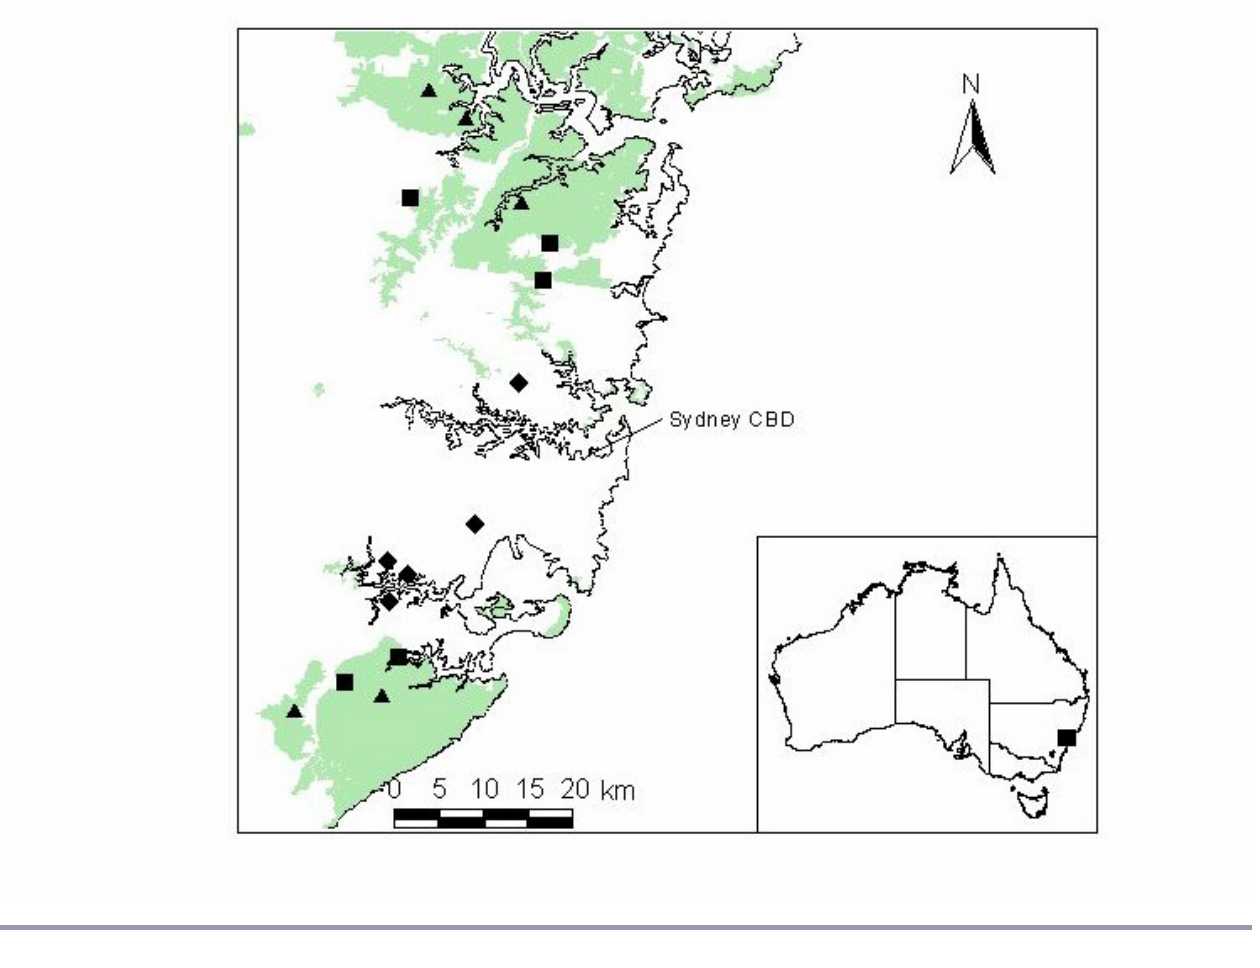
Fig. 1 . Location of small remnant (diamond), edge (square), and interior (triangle) study sites in the Sydney Basin. The shaded area represents the extent of the large national parks and reserves that border the city to the north and south. Unshaded areas represent urban areas. CBD stands for "central business